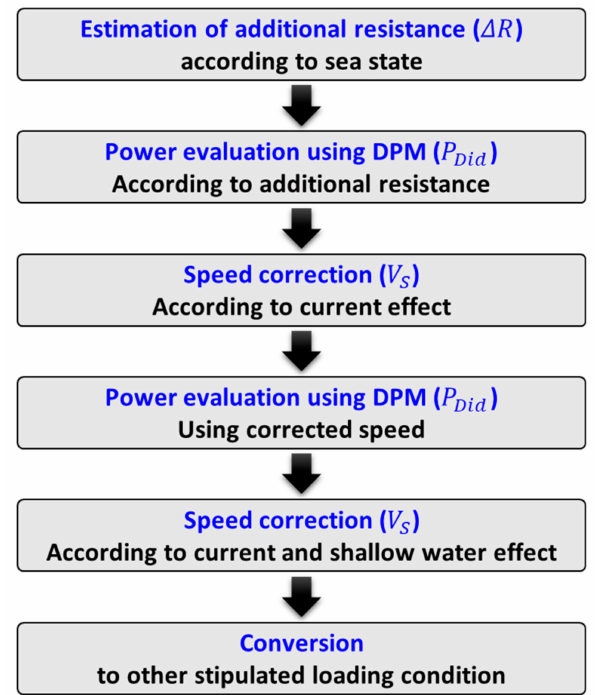
Figure 3. Process of ISO 15016:2015. DPM, direct power method.